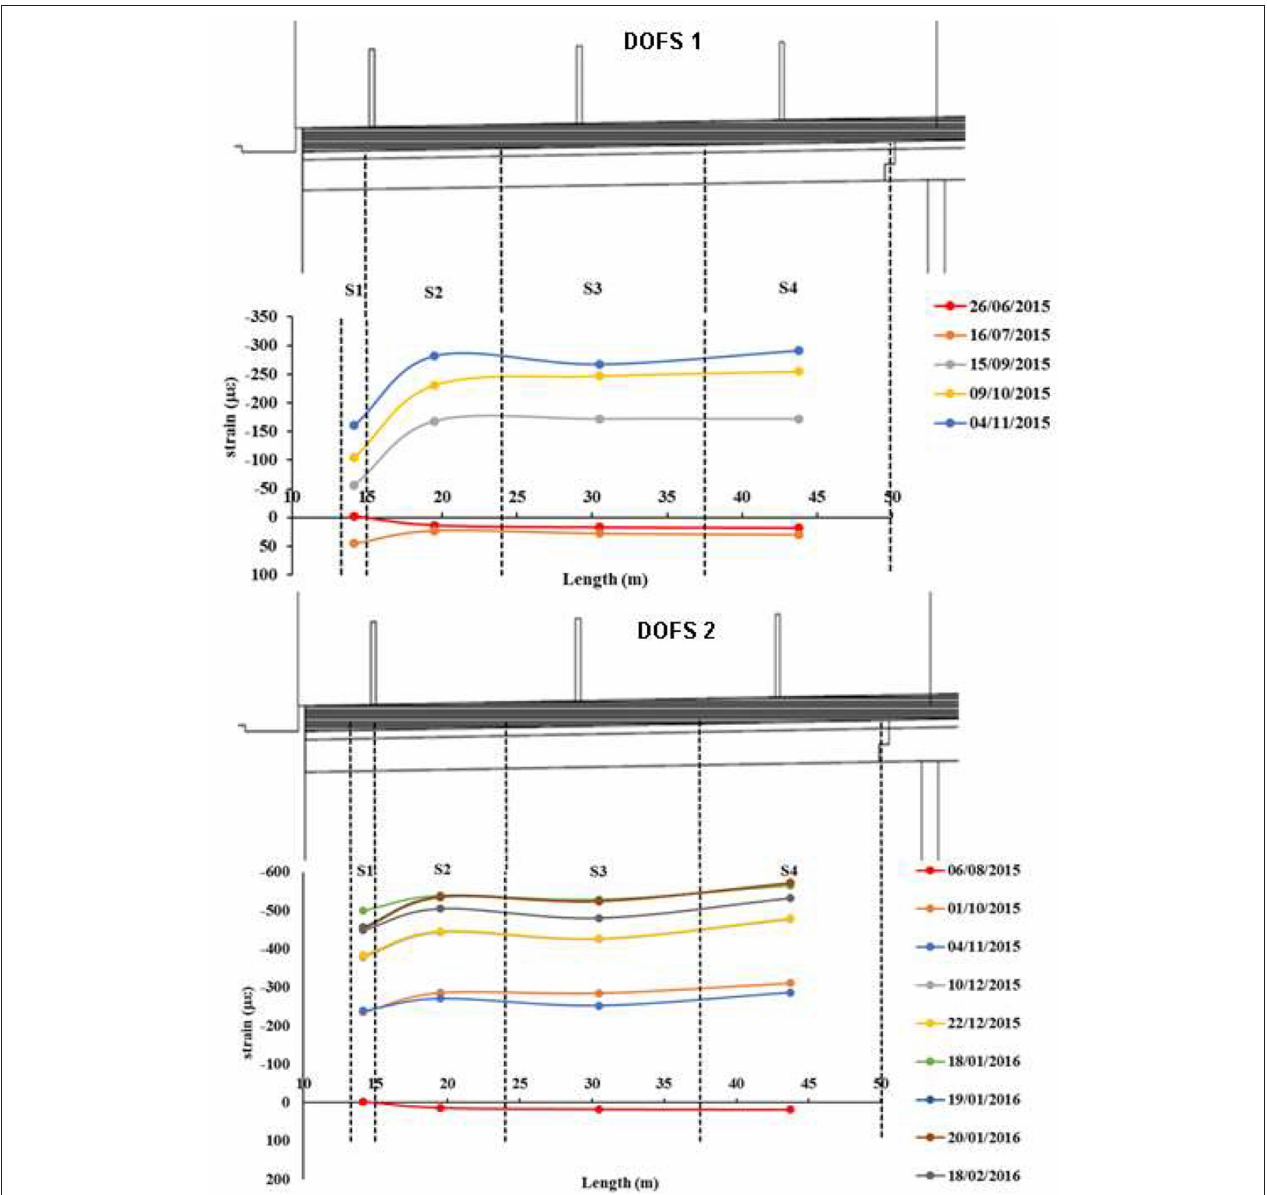
FIGURE 17 | Mean mechanical distribution measured by DOFS 1 (Top) and DOFS 2 (Bottom)